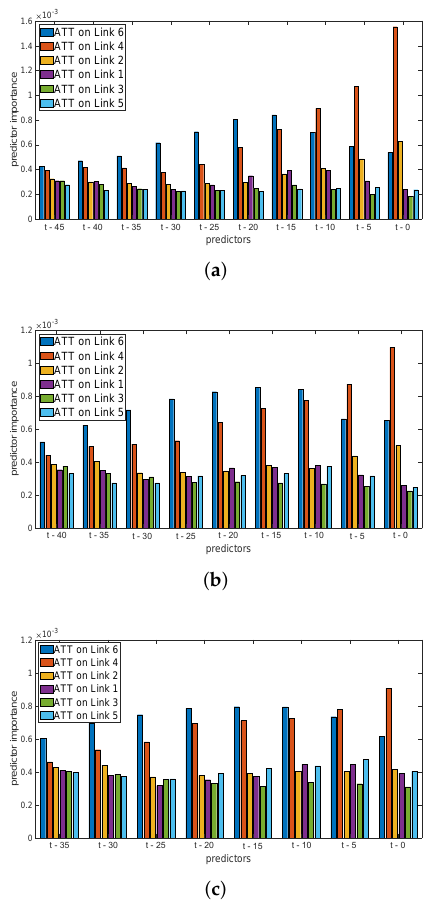
Figure 4. Predictor importance in classifiers at link 4, on Mondays. ( a ) ATTs up to t − 45min.; t (cid:48) = 5min. ( b ) ATTs up to t − 40min.; t (cid:48) = 10min. ( c ) ATTs up to t − 35min.; t (cid:48) =